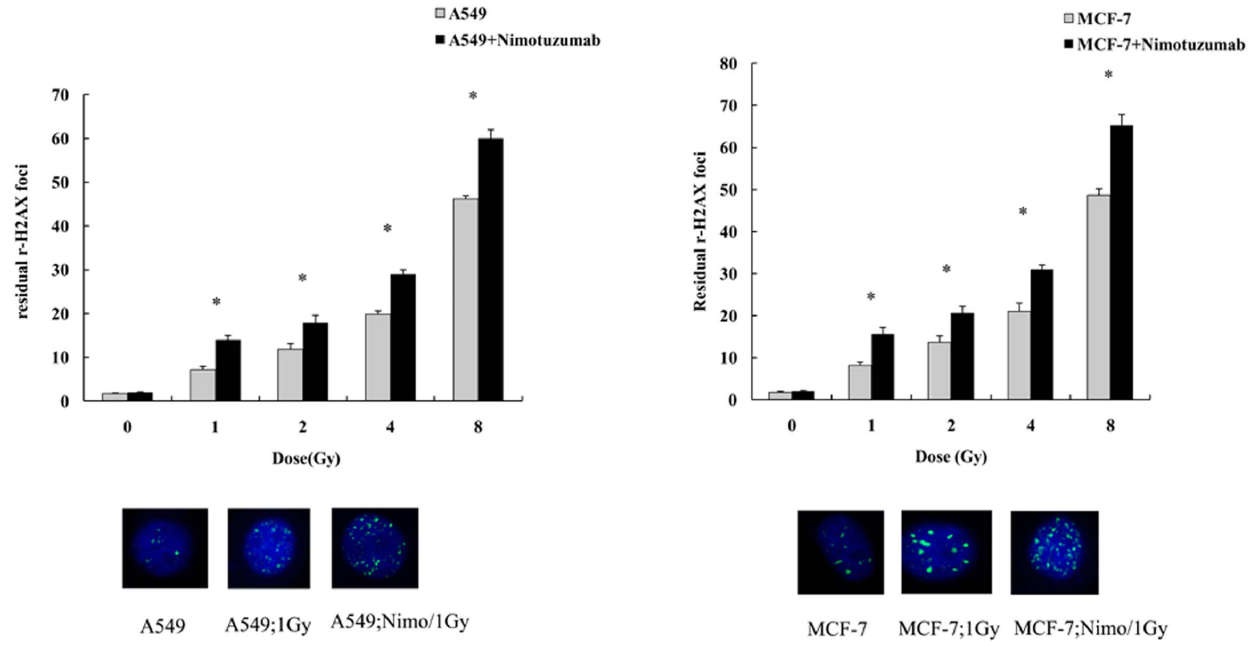
Figure 4. Quantification of residual c -H2AX 24 h after radiation with different doses. A549 and MCF-7 cells were pretreated with or without 700 nM nimotuzumab for 24 h, and then were radiated with 1, 2, 4 and 8 Gy. Twenty four hours after radiation cells were fixed and incubated with c -H2AX antibody conjugated with FITC. Each bar represents the mean 6 SD of residual c -H2AX foci per cell. For each data point at least 300 nuclei were evaluated. * indicates significant difference (P , 0.05). The images below are representative nuclei with c -H2AX foci under immunofluorescent microscopy, treated with 1Gy or 1Gy combined with nimotuzumab.